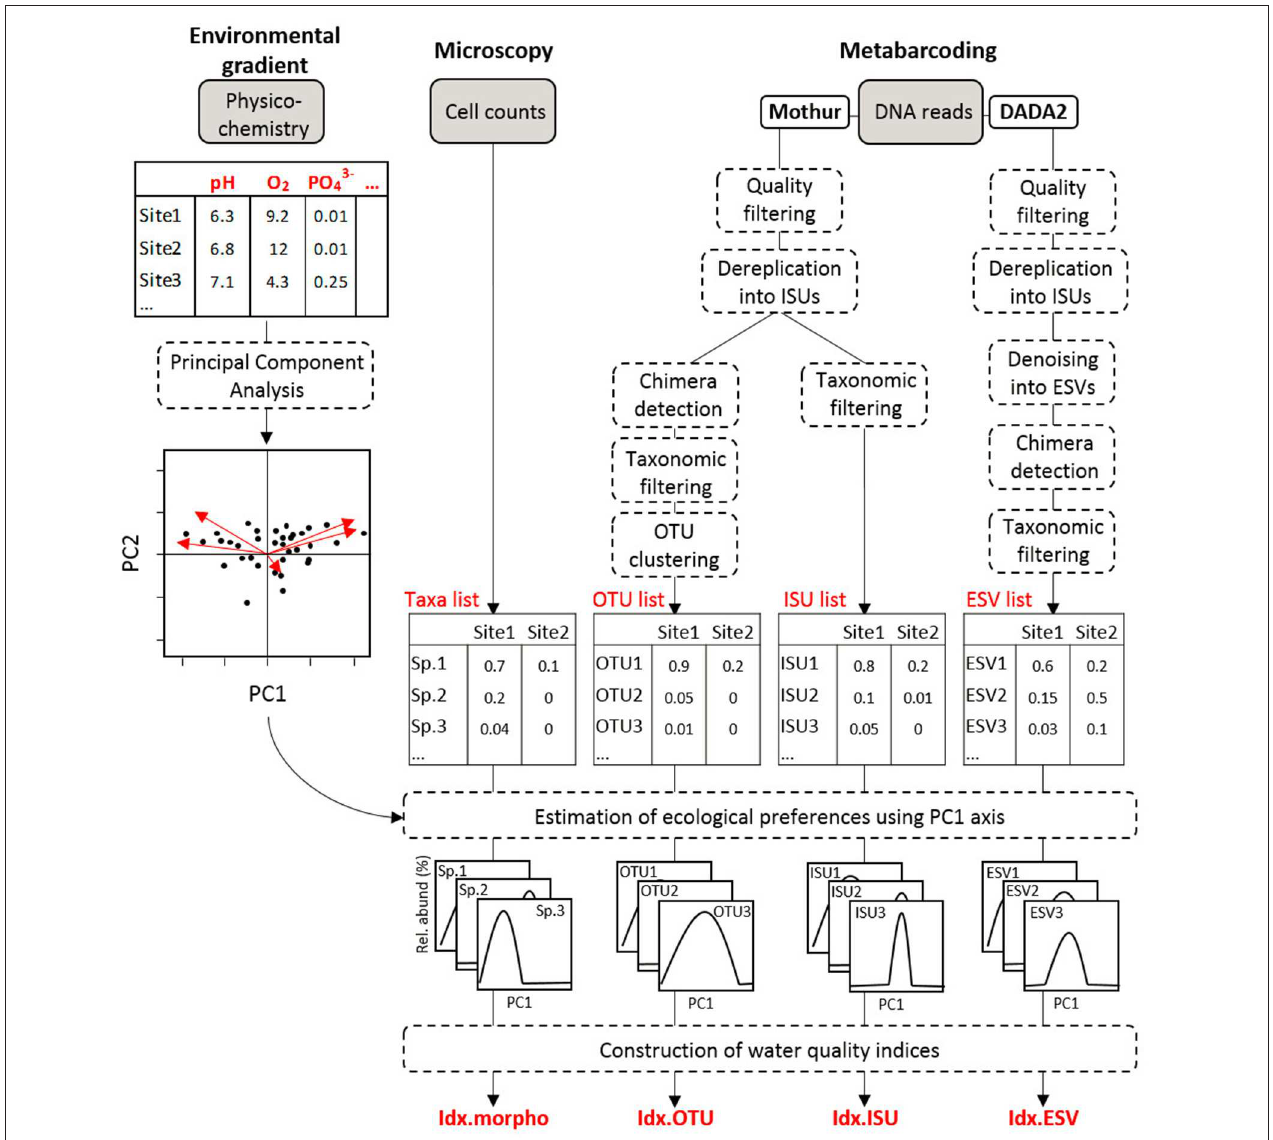
FIGURE 1 | Overview of the analyses. The diagram indicates the steps to compute the four indices based on microscopic data (Idx_morph) and on metabarcoding data (Idx_OTU, Idx_ESV, and Idx_ISU).